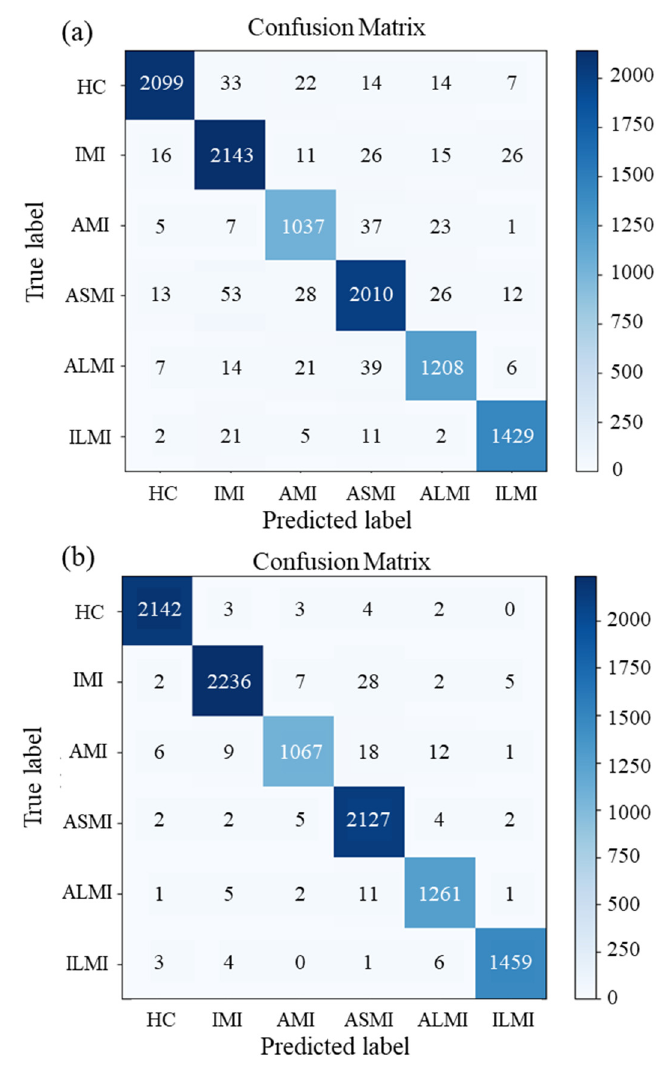
Figure 11. Confusion matrix. ( a ) LSTM. ( b ) BiLSTM.